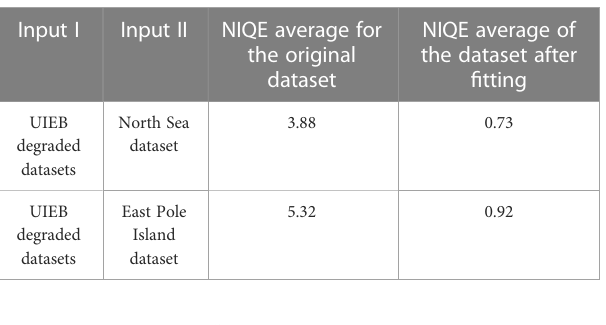
TABLE 1 Comparison of results before and after using the underwater dataset fi tting model.